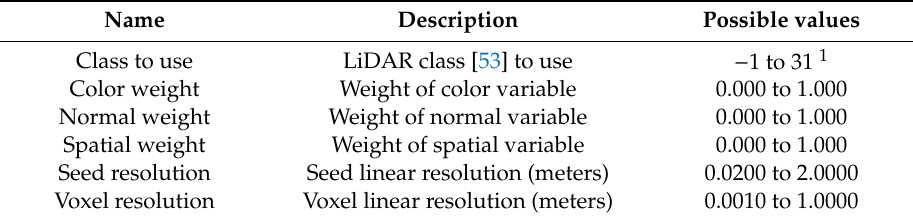
Table 6. List of the editable parameters of the convex hull cluster.